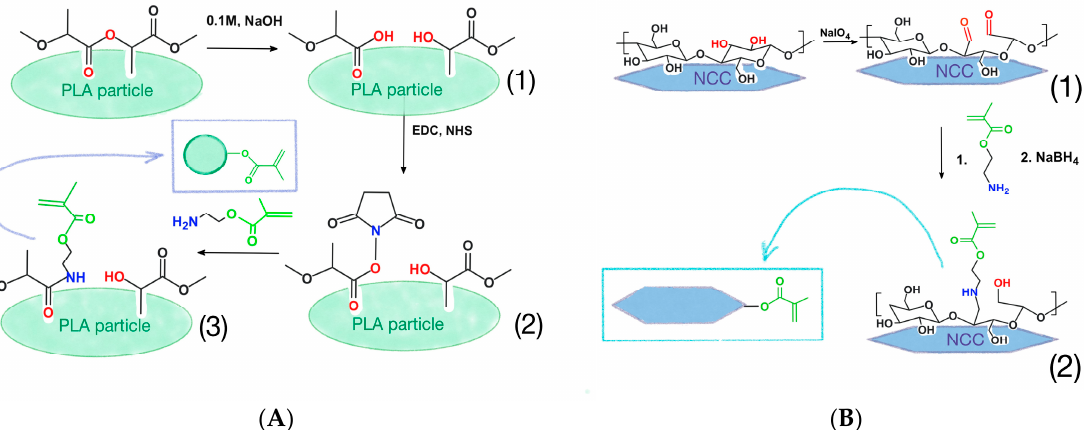
Figure 2. The schemes of methacrylated particles formation via reaction with 2-aminoethylmethac- rylate: ( A ) – modification of PLA particles; ( B ) – modification of NCC